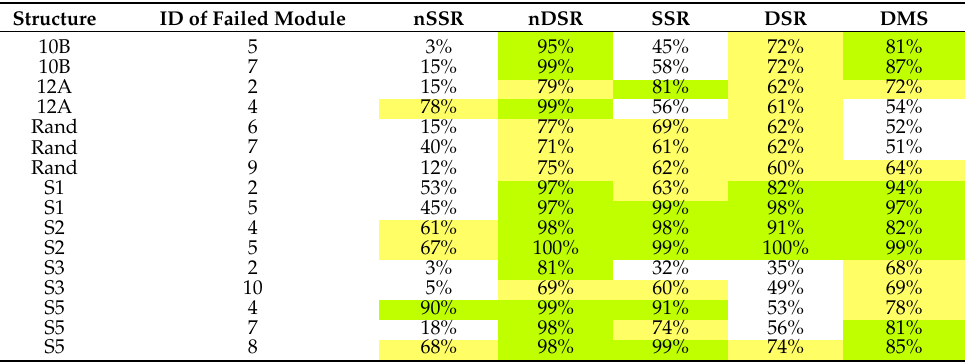
Table 4. Proportions of runs completed without timing out for the self-repair strategies under comparison. Yellow cells mark situations where, for a given structure and failed robot, a particular strategy achieved ≥ 60% success, green cells indicate completion rates ≥ 80%. Averages across all structures and failures tested give: nSSR 37%, nDSR 90%, SSR 72%, DSR 68% and DMS 76%. This indicates that both the motion involved in Dynamic strategies and the ability to self-repair both provide reliability advantages over static-self-assembly-based nSSR. SSR’s higher proportion of completed runs within the time limit suggests that DSR’s speed advantage is traded against a reduced reliability. As well as a higher averaged completion percentage than the standard DSR strategy, DSR with DMS managed a completion rate above 80% in 43% of scenarios to DSR’s